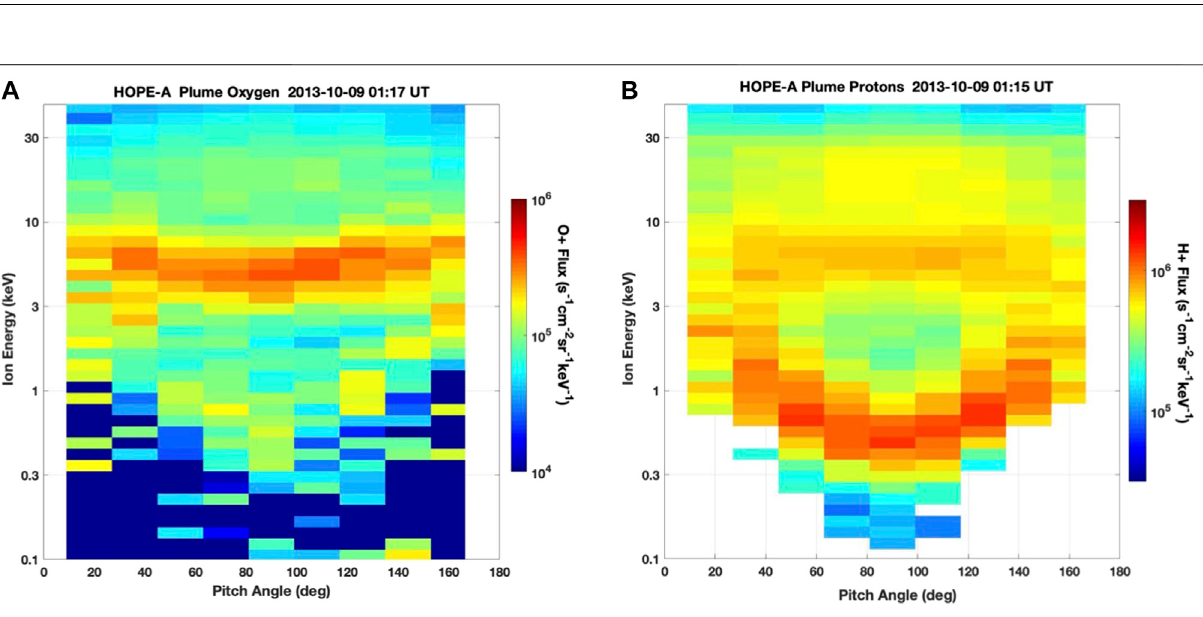
Frontiers in Astronomy and Space Sciences |